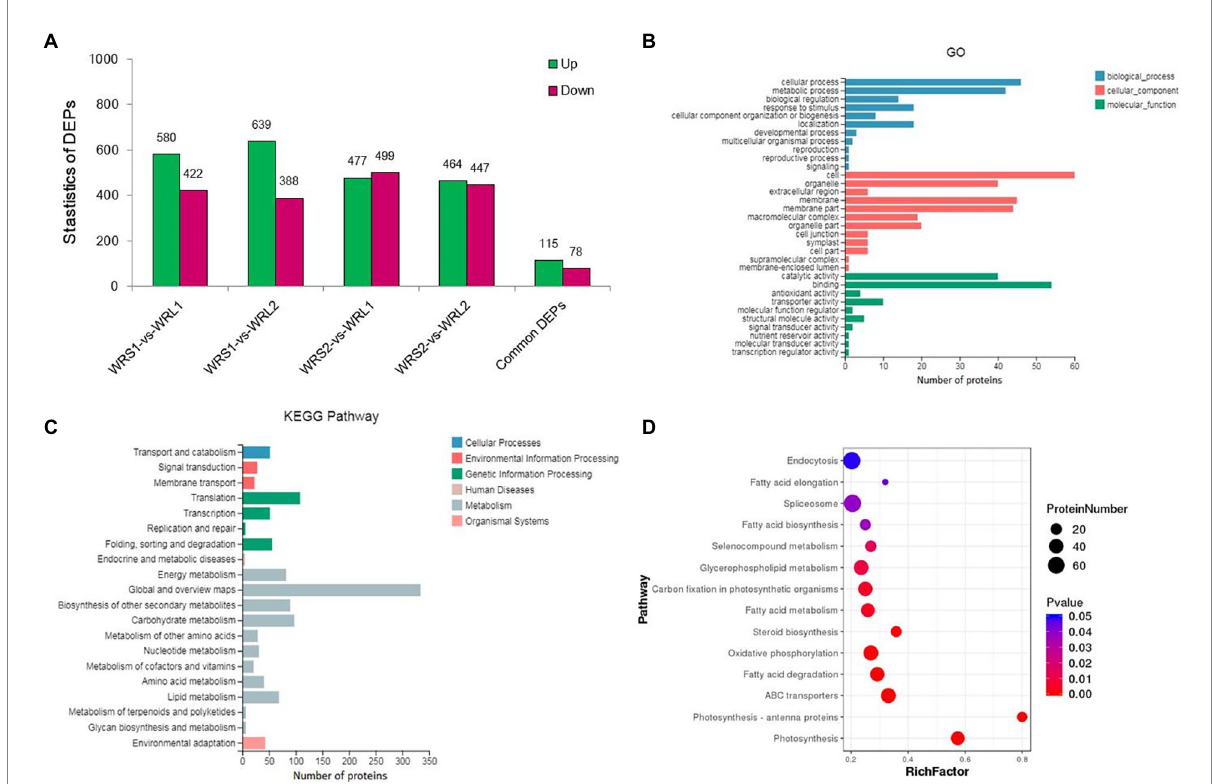
FIGURE 4 Statistics and annotation of the DEPs in short and long radicles of wheat. (A) Venn diagram of the number of proteins identified in 3 replicates; (B) Number of DEPs in pair-wise comparisons; (C) DEP-enriched GO annotations; (D) DEP-enriched KEGG